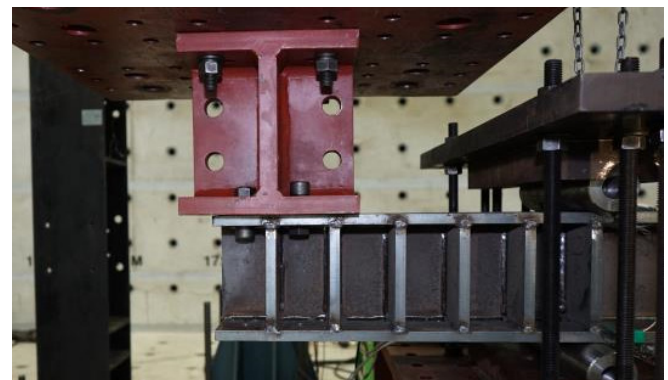
Figure 12. Test Setup/Displacement Measurements.